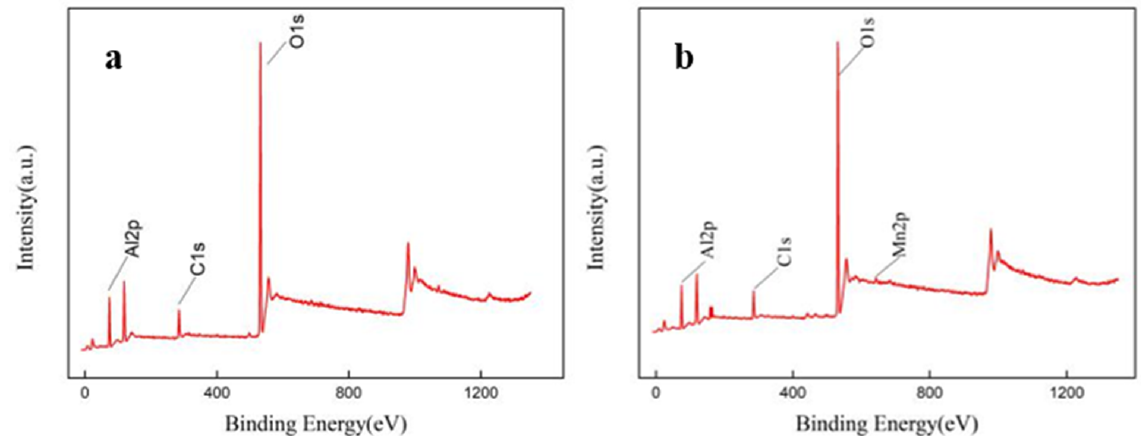
Figure 4. XPS pattern of AA ( a ) and MnOOH-supported AA particles ( b ).